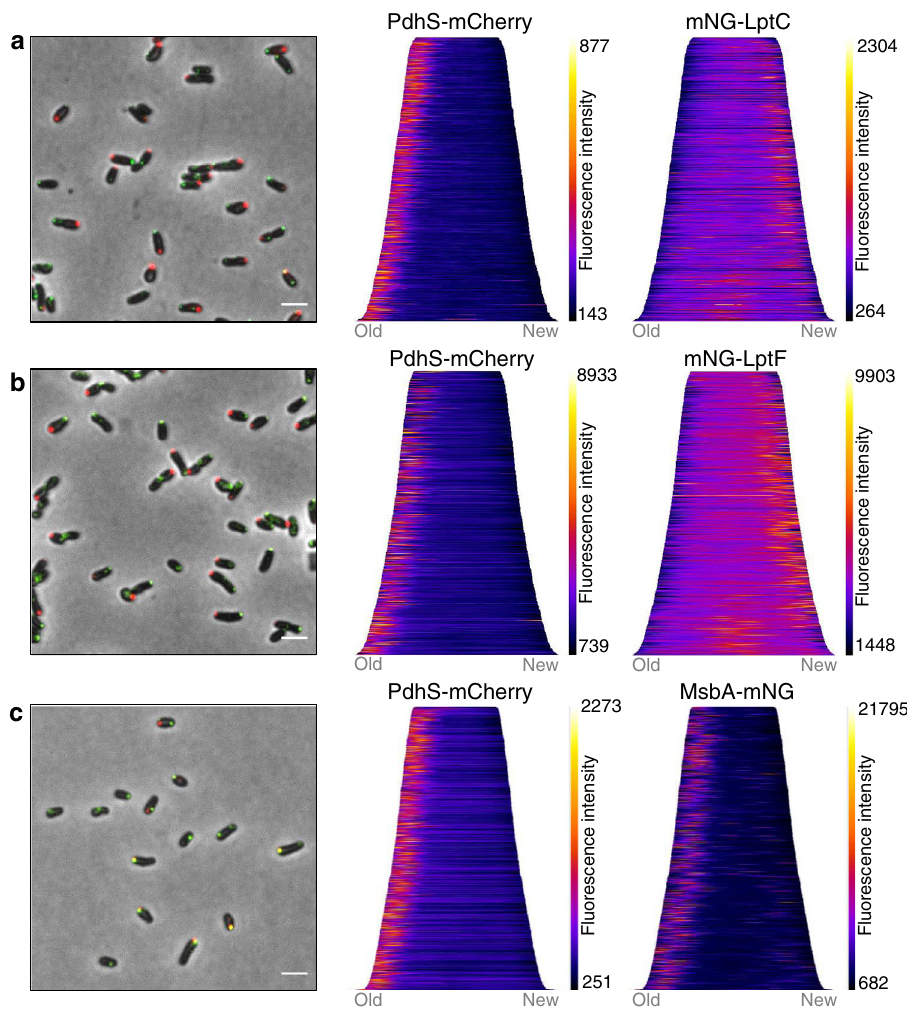
Fig. 2 | LptC, LptF and MsbA localization. Representative merged microscopy pictures and demograph analyses of ( a ) mNG-lptC ( n =723 bacteria), ( b ) mNG-lptF ( n =1398bacteria),and( c ) msbA-mNG ( n =693bacteria)co-expressingtheoldpole marker PdhS-mCherry. Both mNG-LptC ( a ) and mNG-LptF ( b ) are detected at the growth sites while MsbA-mNG is localized at the old pole ( c ). Scale bars represent 2 µ m. The right panels show demographic representations. The cells were sorted according to their size (from the smallest on top to the largest at the bottom) and